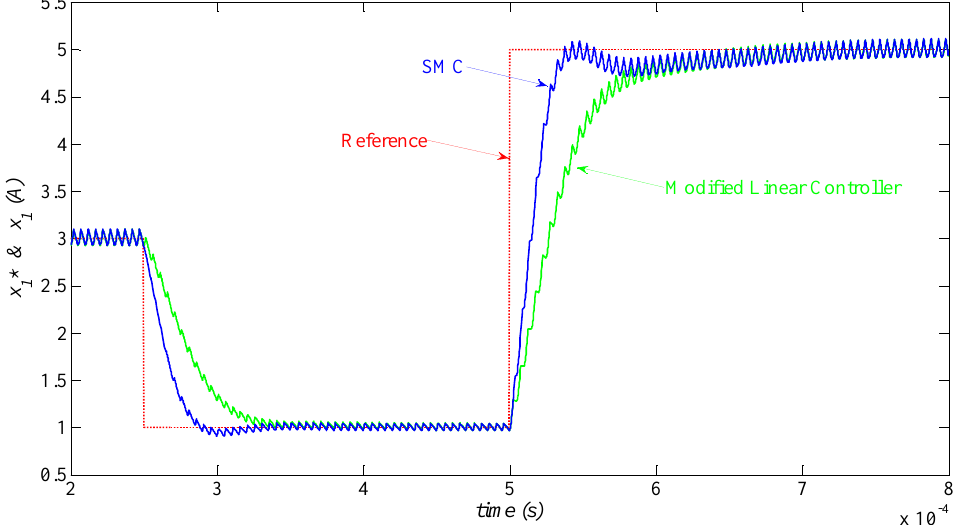
Figure 11. Step response of the proposed controllers considering load uncertainty.